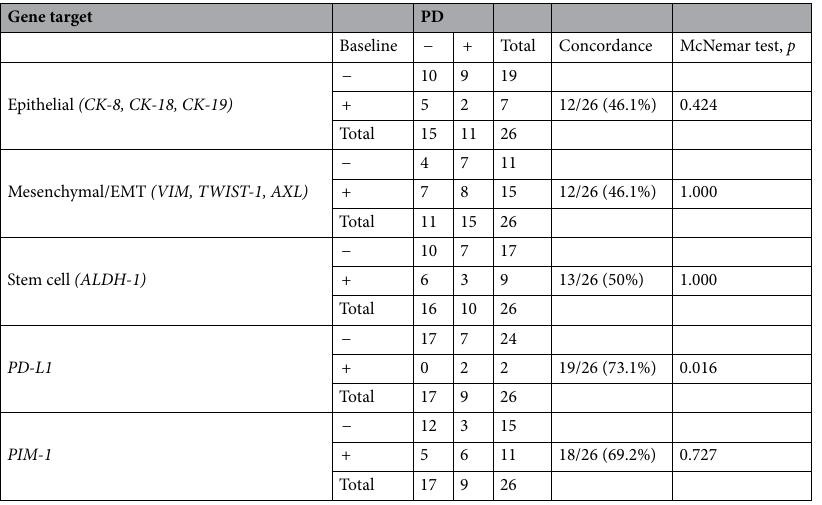
Table 1. Comparison of gene expression in CTC-enriched fractions before treatment with AZD9291 and at progression of disease (PD).